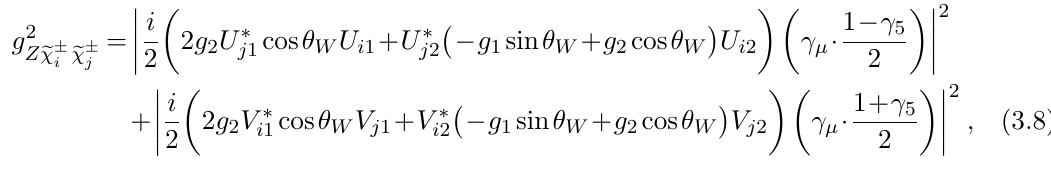
Figure 5. (a) BR( as a function of the in (cid:31) 0 e 1